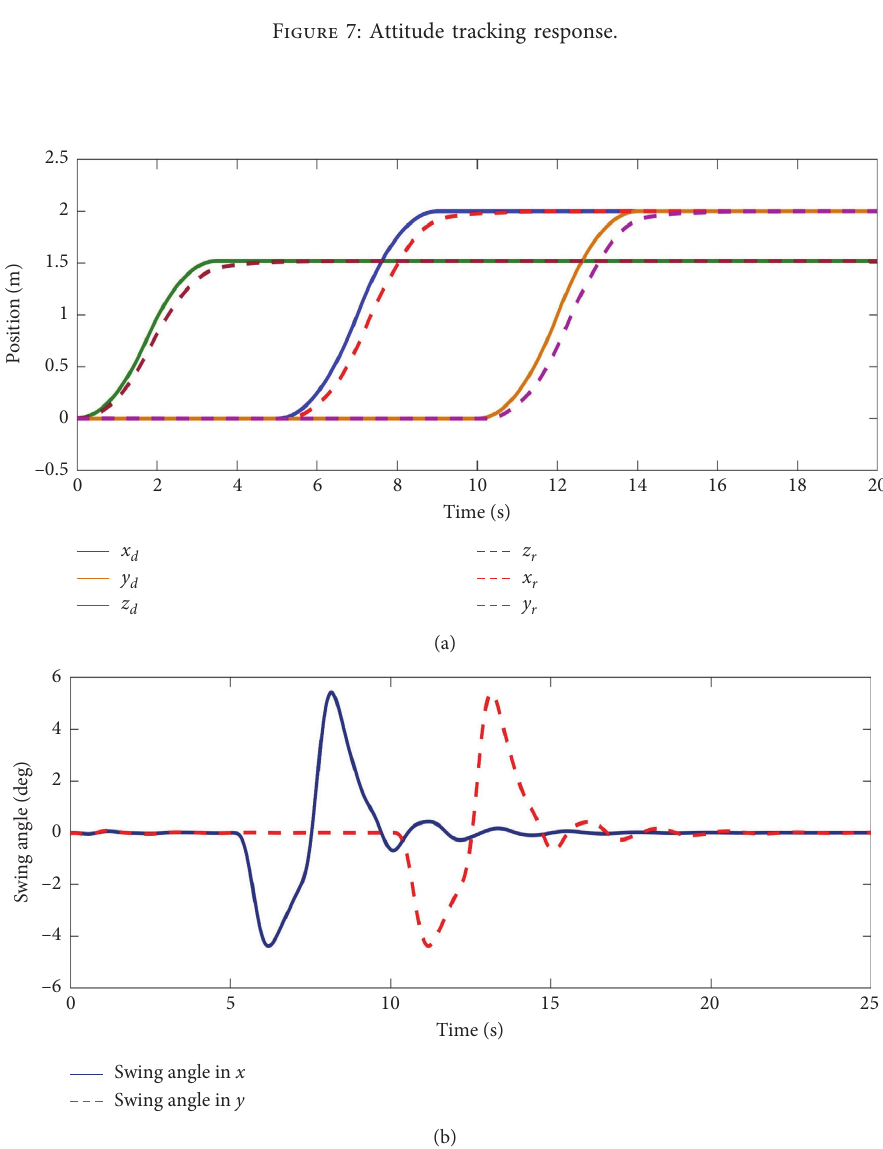
Figure 8: Position and Swing angle during simulation. (a) Position tracking response. (b) Swing angle tracking response.